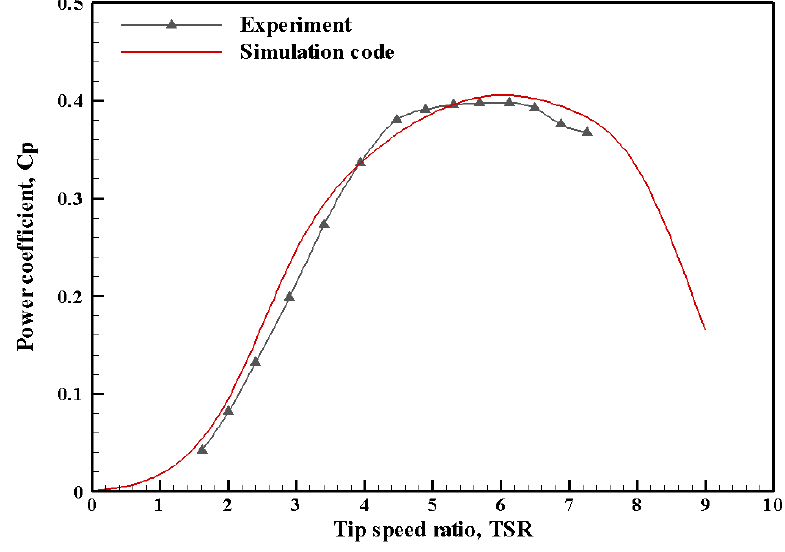
Figure 15. Comparison of the power coefficients between experimental and simulation results at wind speed of 12